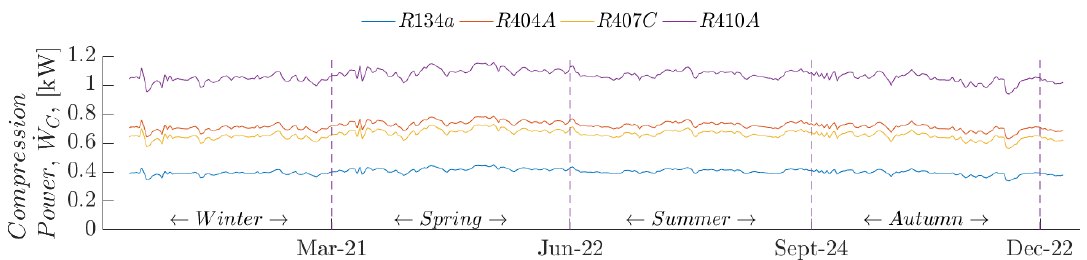
Energies 2019 , 12 , x FOR PEER REVIEW Figure 12. Compression power input for all working fluids throughout the year for all refrigerants.